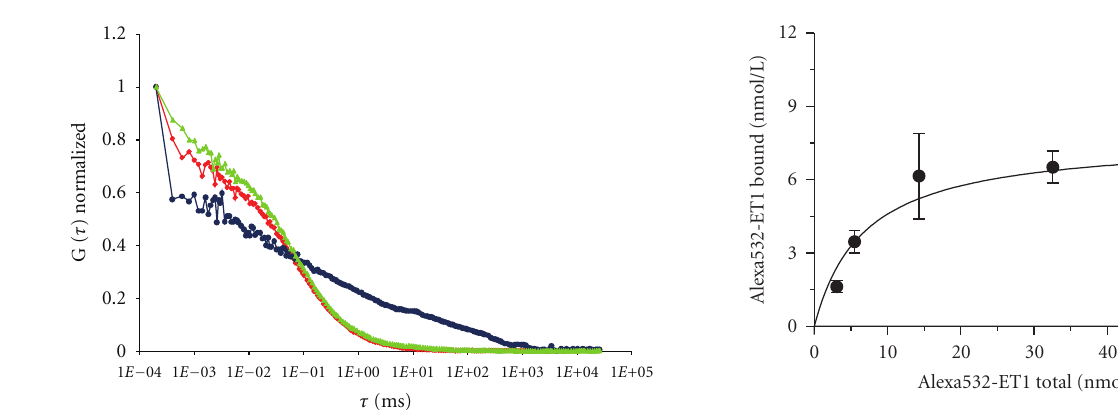
Figure 3: Alexa532-ET1 binding to vascular smooth muscle cells. Averaged bound Alexa532-ET1 concentration versus the total Alexa532-ET1 concentration. The bound Alexa532-ET1 fraction was determined from the autocorrelation function for di ff erent Alexa532-ET1 concentrations ( n = 5).